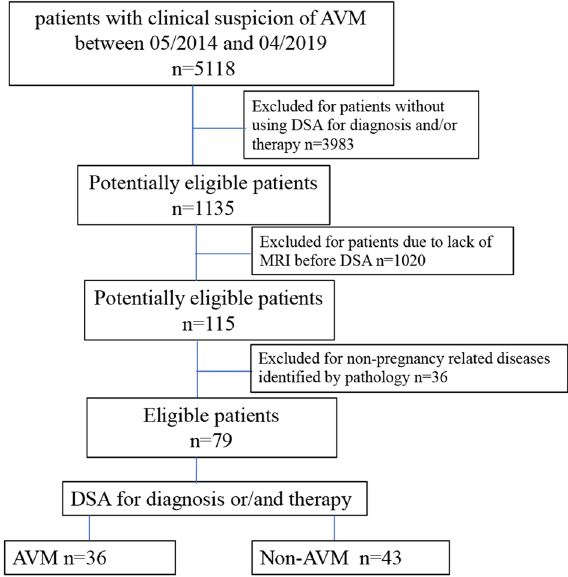
Figure 4. Flowchart showing the inclusion and exclusion criteria.